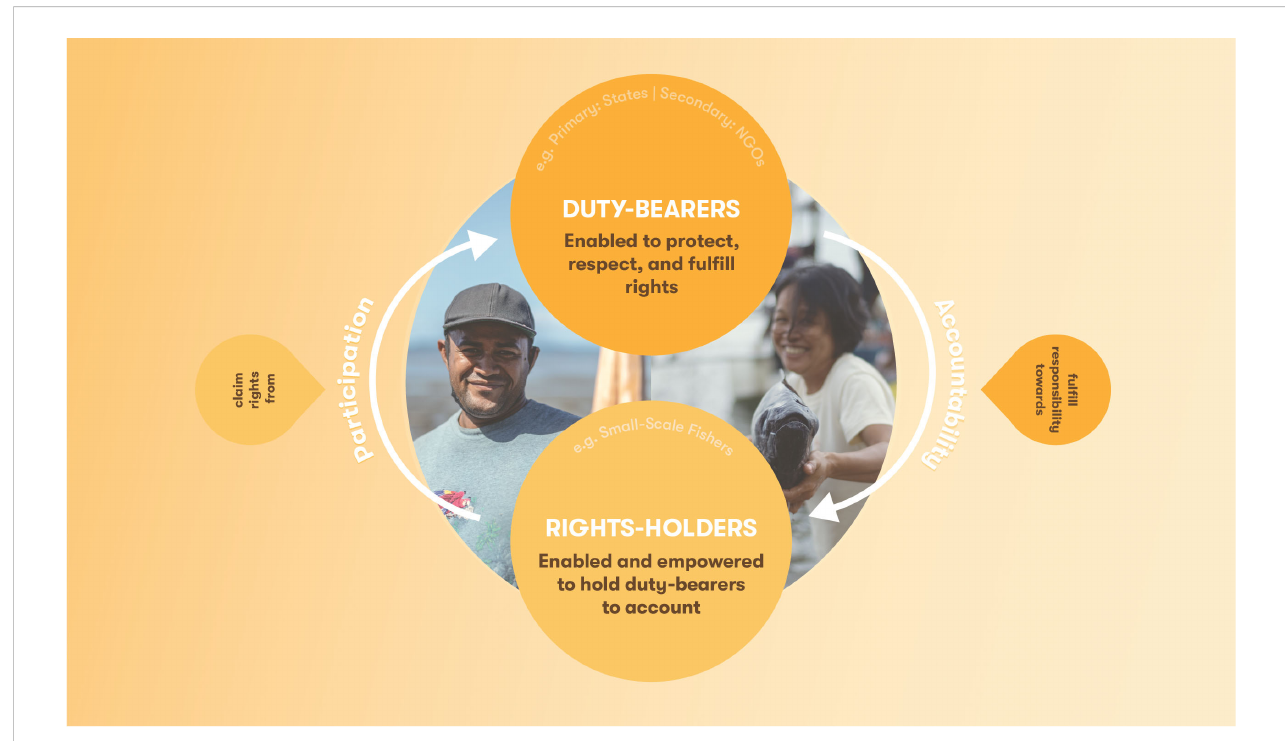
FIGURE 2 The relationship between Duty-Bearers and Rights-Holders. Photographers: Tom Vierus (left) and Rebecca Weeks